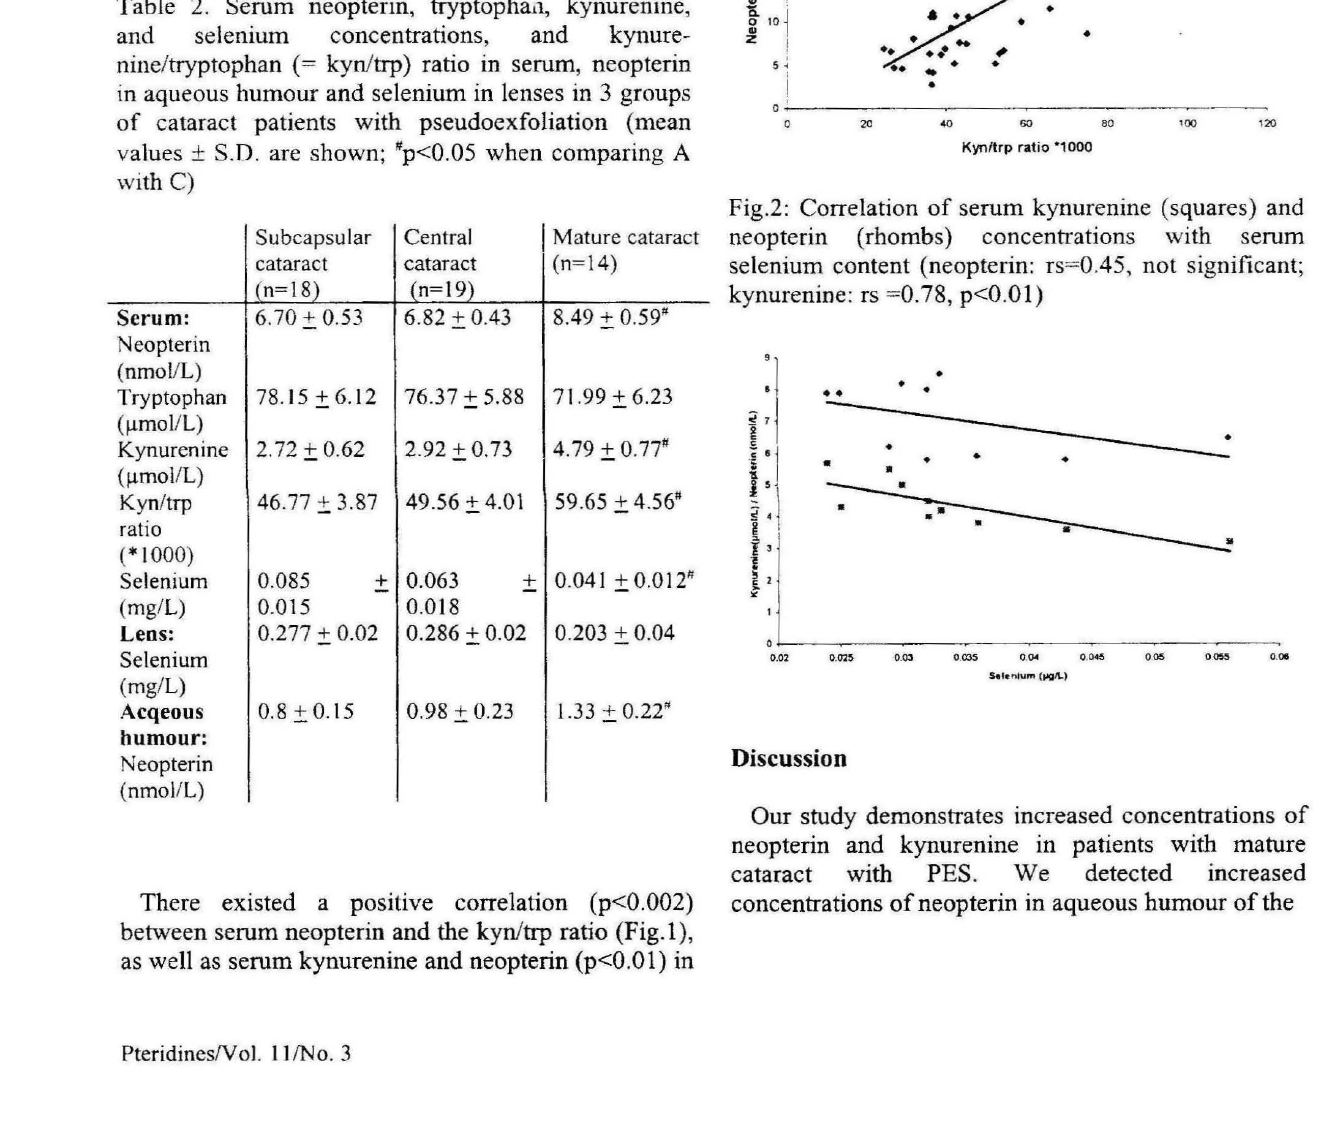
Table 2. Serum neopterin, tryptoph,L.1, kynurenine, and selenium concentrations, and kynure nine/tryptophan (= kyn/trp) ratio in serum, neopterin in aqueous humour and selenium in lenses in 3 groups of cataract patients with pseudoexfoliation (mean values ± S.D. are shown; #p<0.05 when comparing A with C)